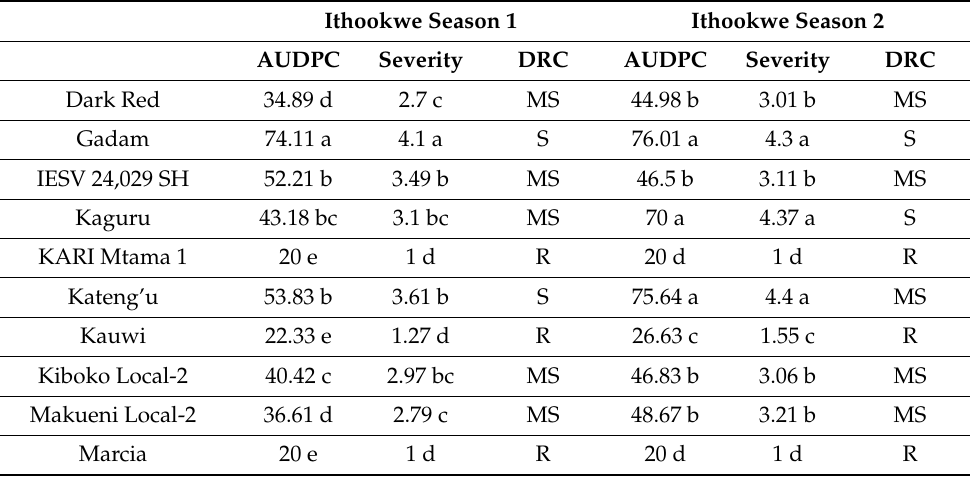
Table 7. Area under the disease progress curve (AUDPC), disease severity scores and disease reaction types in 14 sorghum genotypes following inoculation with Colletotrichum sublineolum under field conditions at